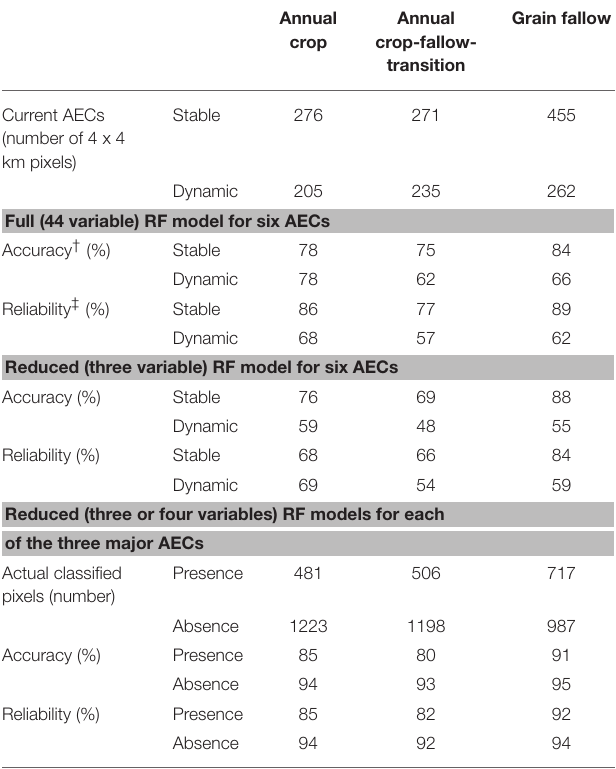
TABLE 3 | Agro-ecological classes (AECs) in present time period and cross validation accuracy and reliability of full and reduced variable Random Forest (RF) models for six and three